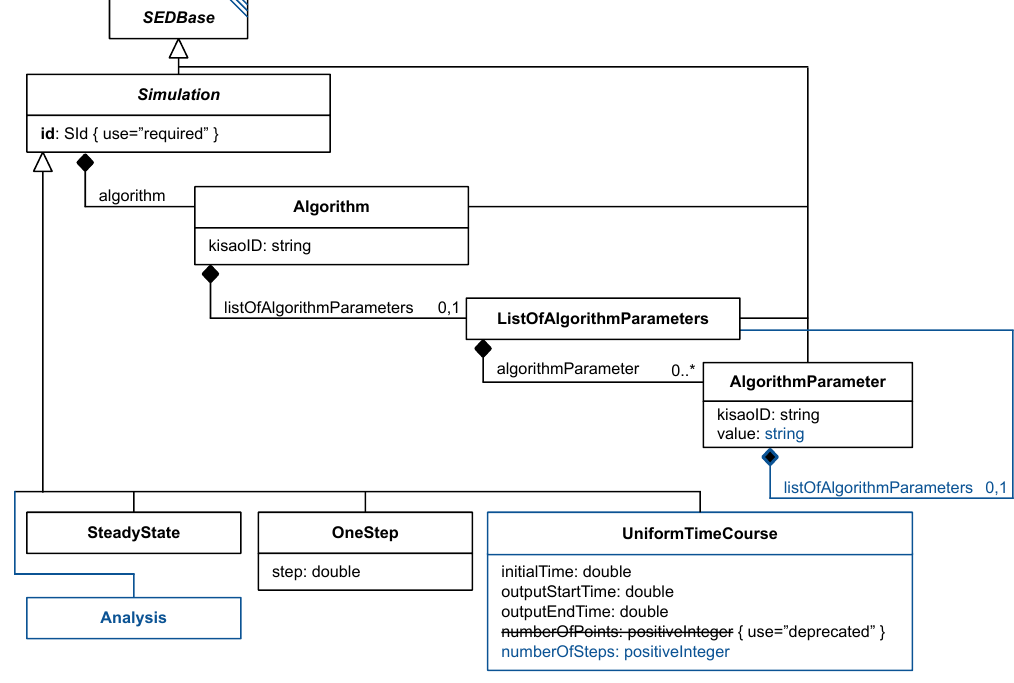
Figure 2.11: The SED-ML Simulation